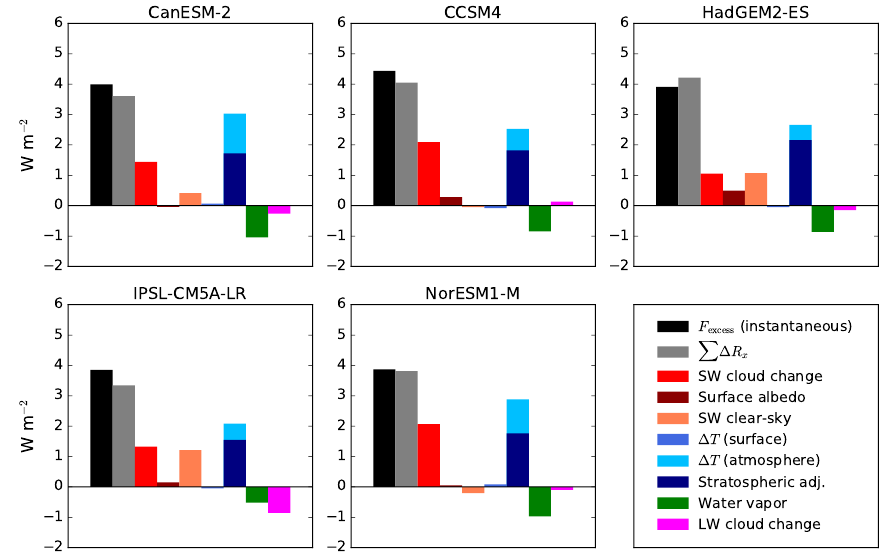
Figure 11. As in Fig. 10 but with excess solar forcing calculated using instantaneous instead of effective CO 2 radiative forcing. The navy blue bar indicates the reduction in OLR due to stratospheric temperature adjustment from CO 2 quadrupling given by Zhang and Huang (2014), to illustrate the portion of the atmospheric temperature adjustment to G1 attributable to stratospheric cooling.